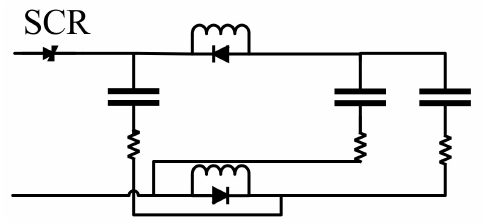
Figure 9. Structure of typical Z-source